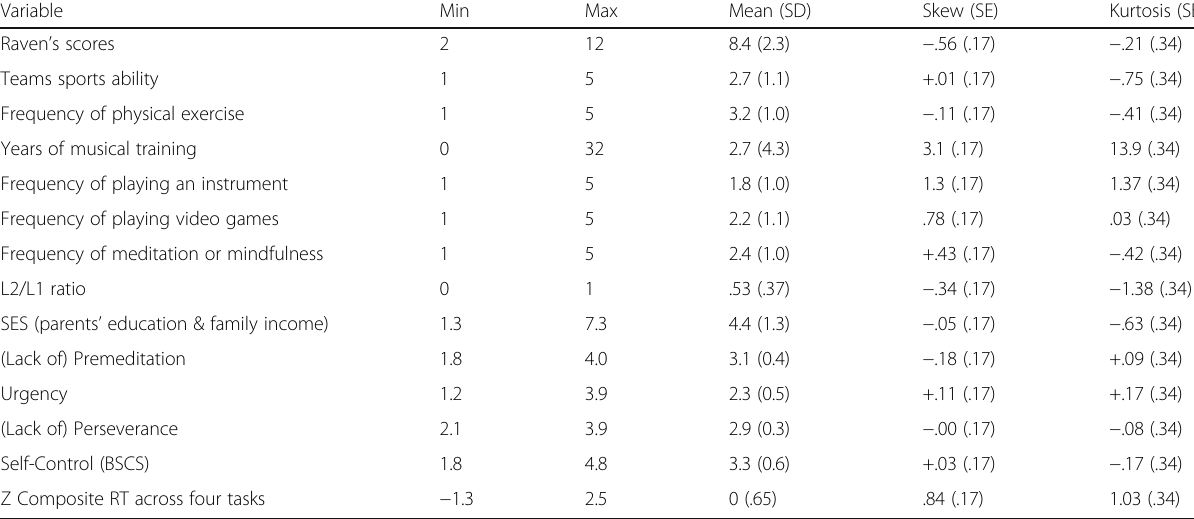
Table 7 Distributional characteristics of the predictor and outcome variables across 201 participants Variable